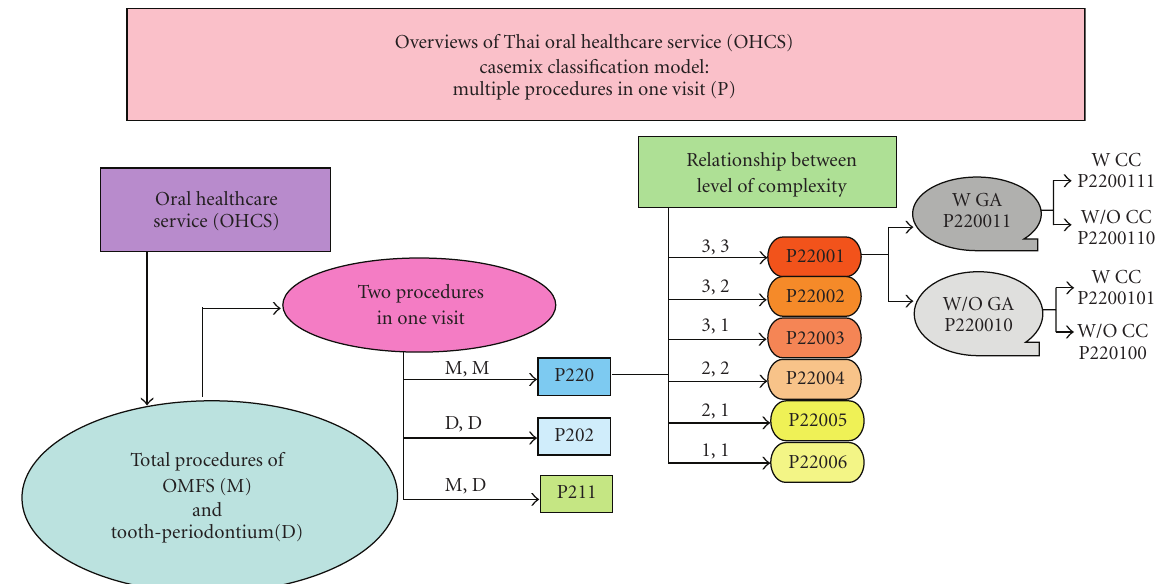
Figure 5: Diagram demonstrates overviews of the Thai oral healthcare service (OHCS) casemix classification model of multiple procedures in one visit (P). M = oral and maxillofacial surgery (OMFS), W = with, W/O = without, GA = general anesthesia, CC = complication and